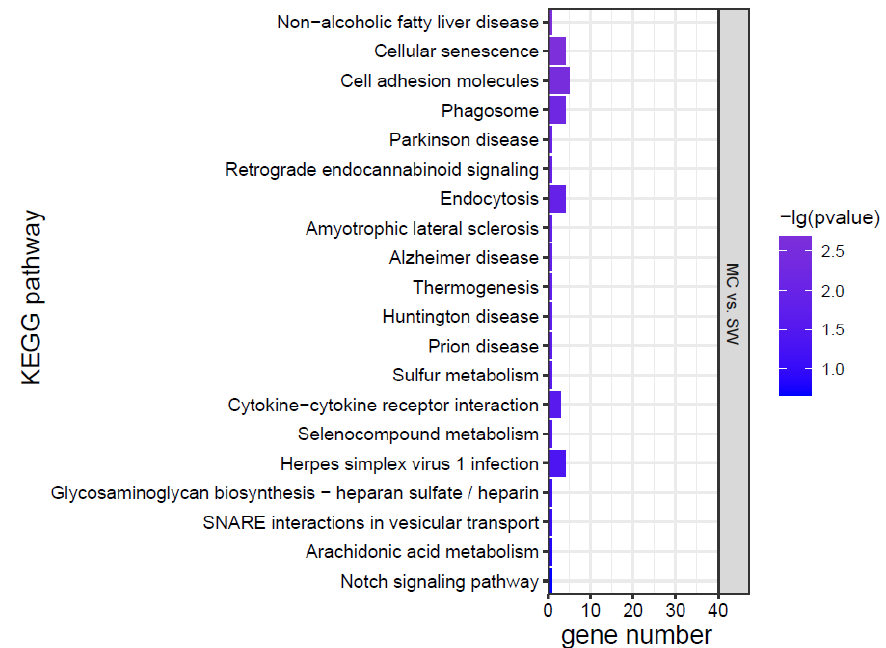
Figure 7. KEGG pathways of marine medaka gills in different treatment groups, p < 0.05 is significant.